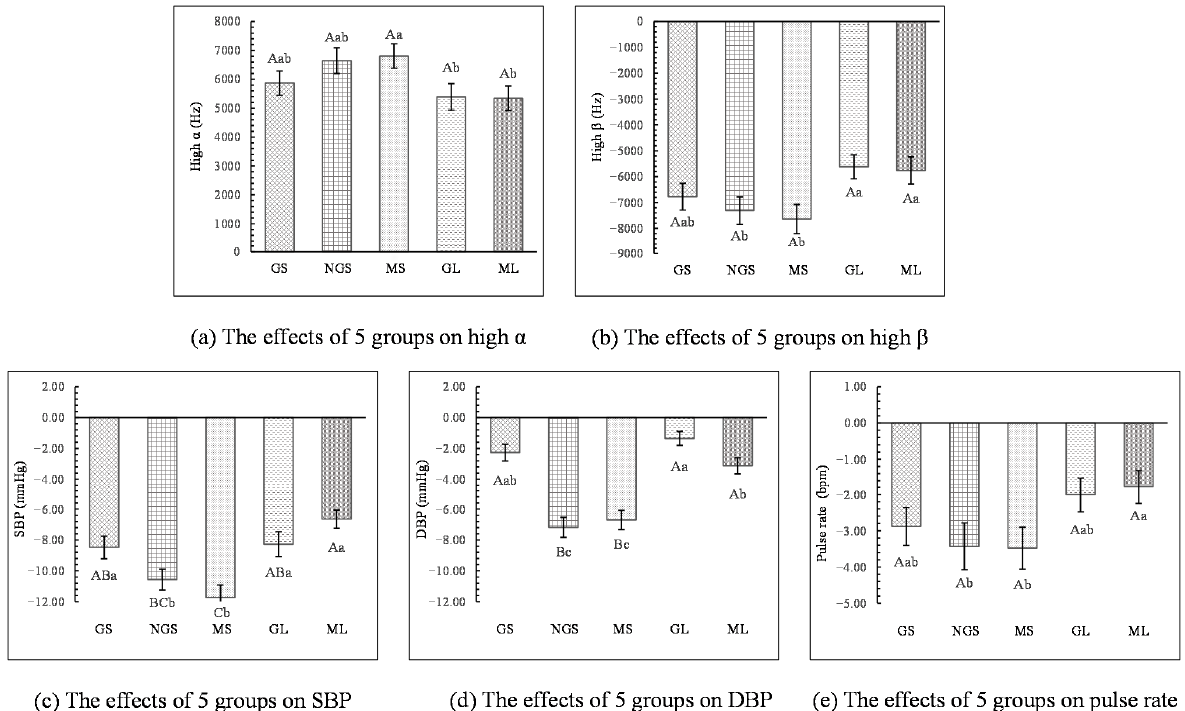
Figure 5. Comparison of the physiological restorative values after the participants viewed five ornamental bamboo groups: GS (green stalk), NGS (non-green stalk), MS (multicolored stalk), GL (green leaf), ML (multicolored leaf). The zero point represents the value measured after participants viewing urban images. SBP: systolic blood pressure; DBP: diastolic blood pressure; n = 300; mean ± SE. Different capital letters: significant differences ( p < 0.01) between five groups. Different lowercase letters: significant differences ( p < 0.05) between five groups. The same letters: no significant differences.